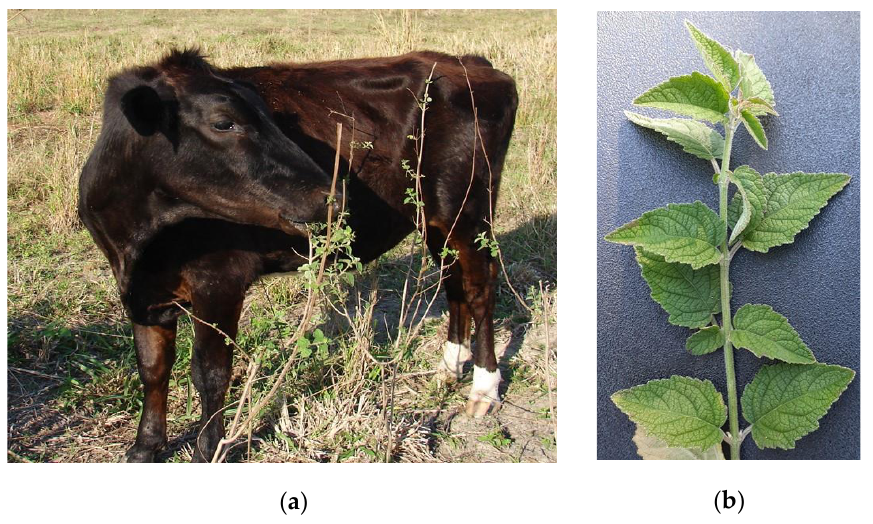
Figure 9. ( a ) Heifer grazing a non-grass plant ( Hyptis pectinata ) [11]. ( b ) Closer view of an example of Hyptis pectinata with concentrations of crude protein, P and Ca of 108, 2.13, and 12.9 g per kg of dry matter, respectively [11].